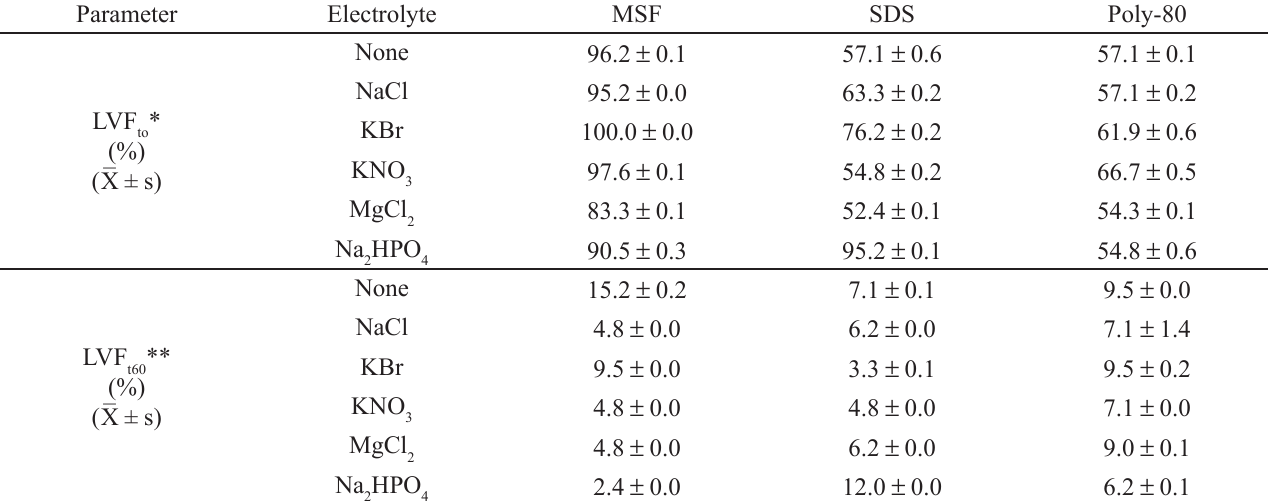
TABLE IV - Percentage liquid retained in foam prepared with mate saponin fraction (MSF), sodium dodecyl sulfate (SDS) and polysorbate 80 (Poly-80) solutions, with and without electrolyte addition